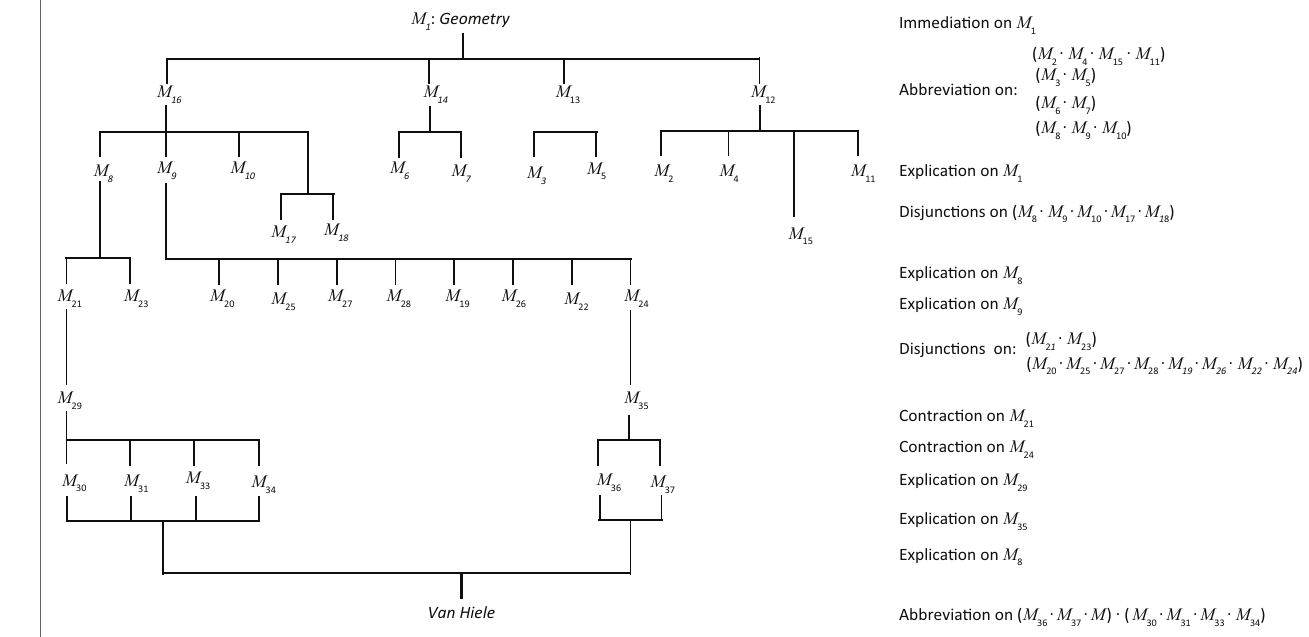
to the insertion of Van 1